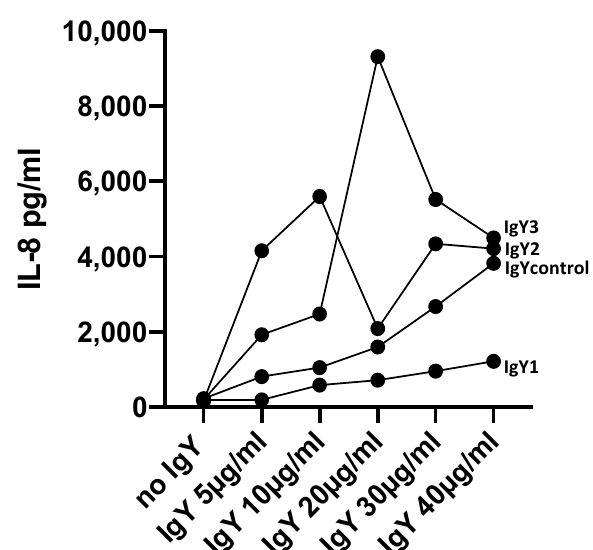
Figure 8. After incubation with avian IgYs for 24 h, osteoblasts were partially detached from the surface which indicates activation.